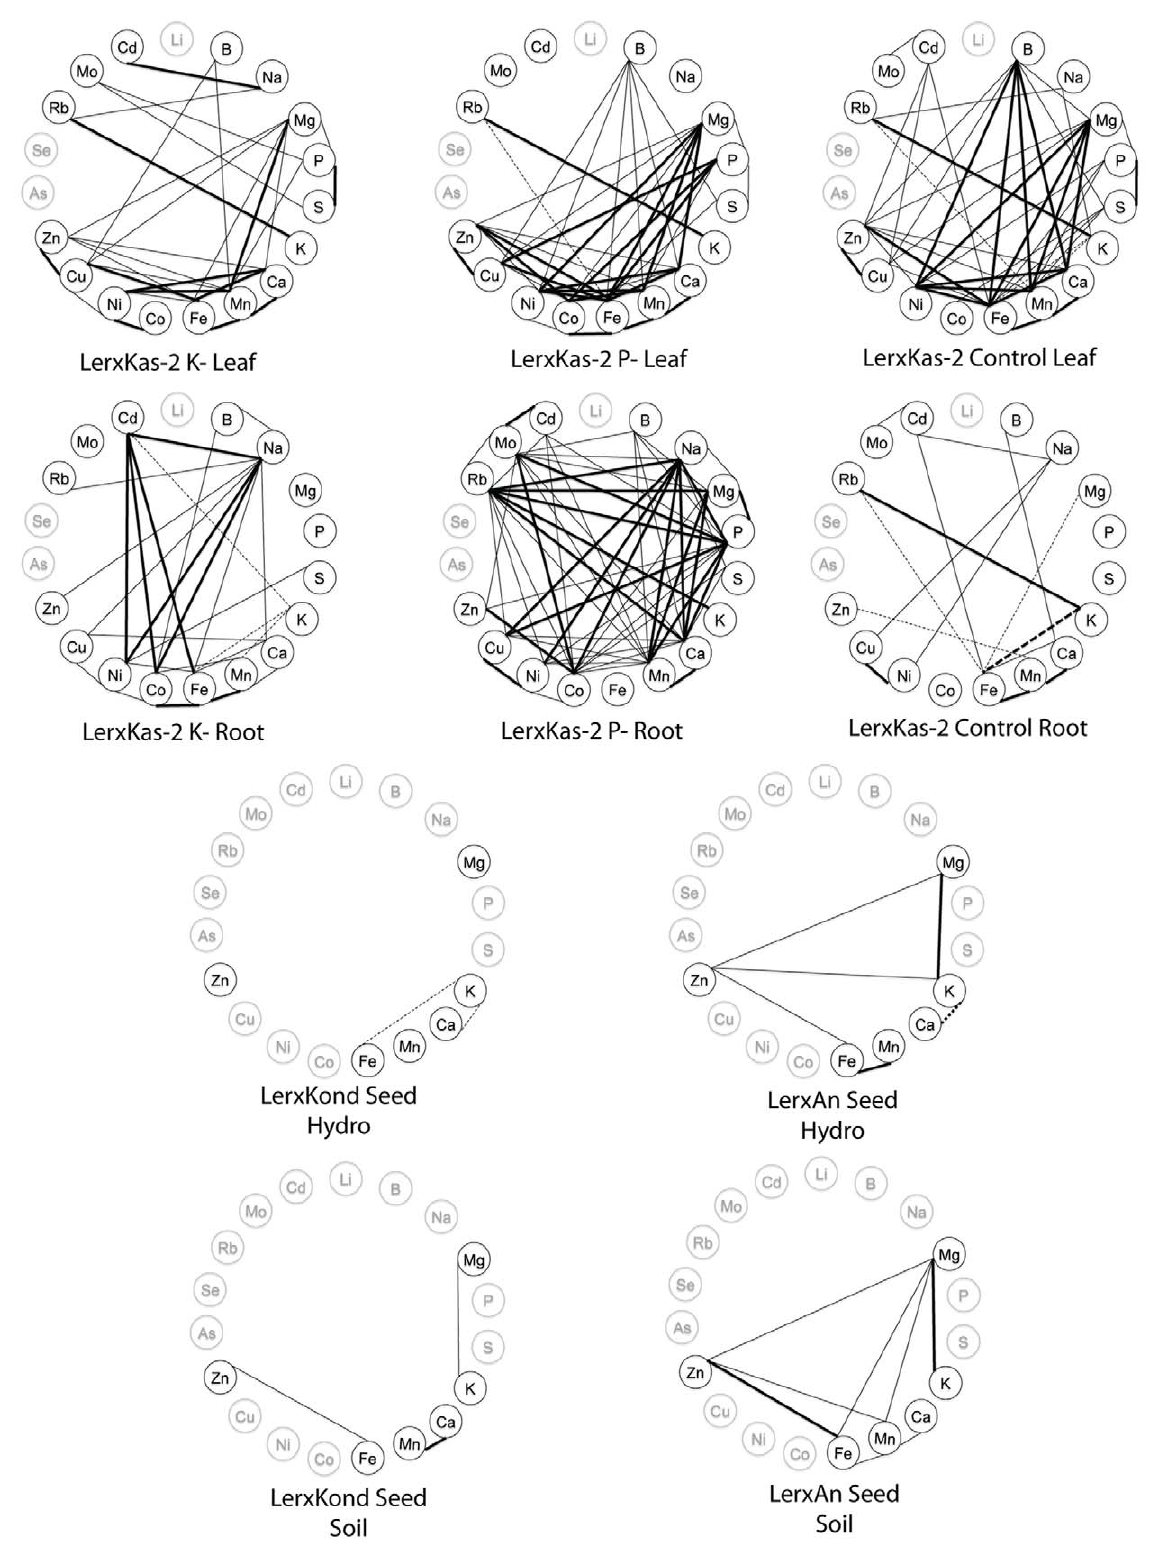
Figure 3. Correlations wheels showing significant correlations between elements within an experiment. A–F are from Prinzenberg et al. [17], with correlations calculated from the original data. G–J are taken from Ghandilyan 2009, [27], Table 3. Only significant correlations (p , 0.001 and R 2 . 0.32) are displayed on each wheel. Positive correlations are denoted by solid lines, negative correlations are denoted by dashed lines. Thick lines indicate R 2 . 0.5, thin lines indicate 0.32 , R 2 , 0.5. Ions not measured in a given experiment are colored in grey.